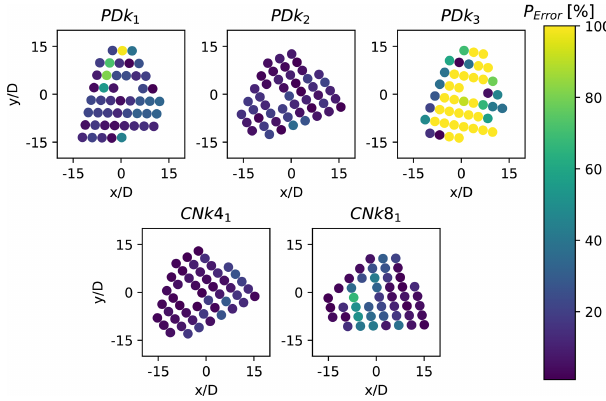
Figure 13. Effect of wind direction on relative power error between LES calculations and field SCADA measurements for the five sim- ulated